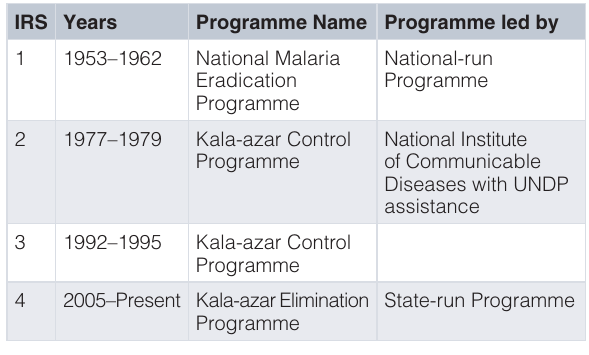
Table 1. Overview of IRS activities for VL in Bihar,